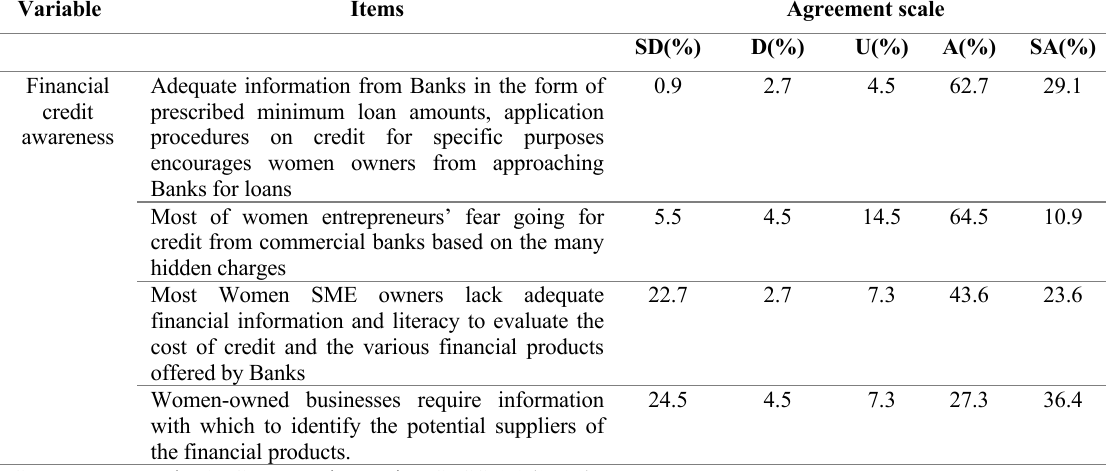
Table 4: Responses on Financial credit